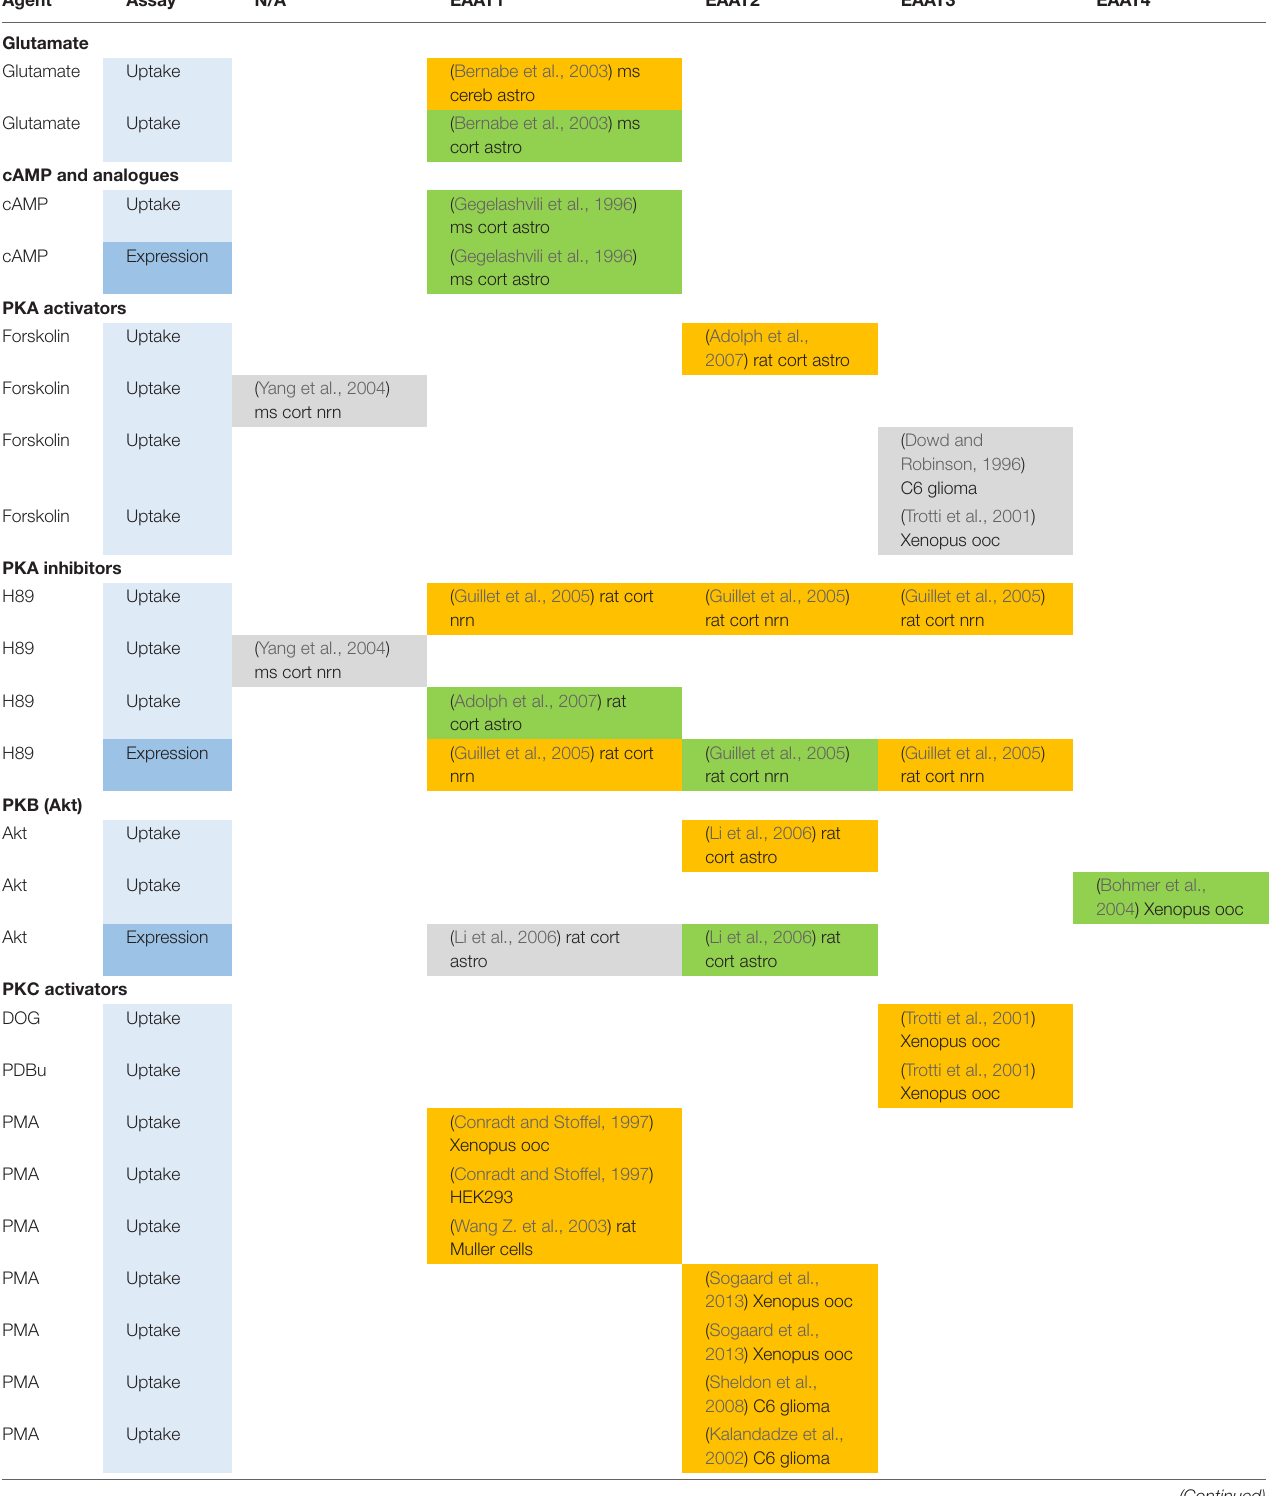
TABLE 1 | Regulating factors of glutamate transporter uptake and expression. Agent